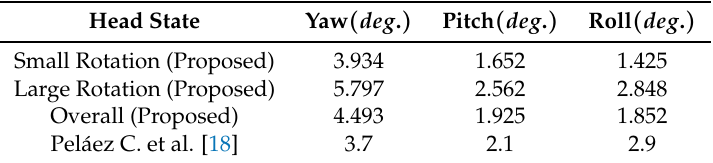
Table 3. The Mean Absolute Error of head pose estimation at different head motions. Head State Yaw ( deg .